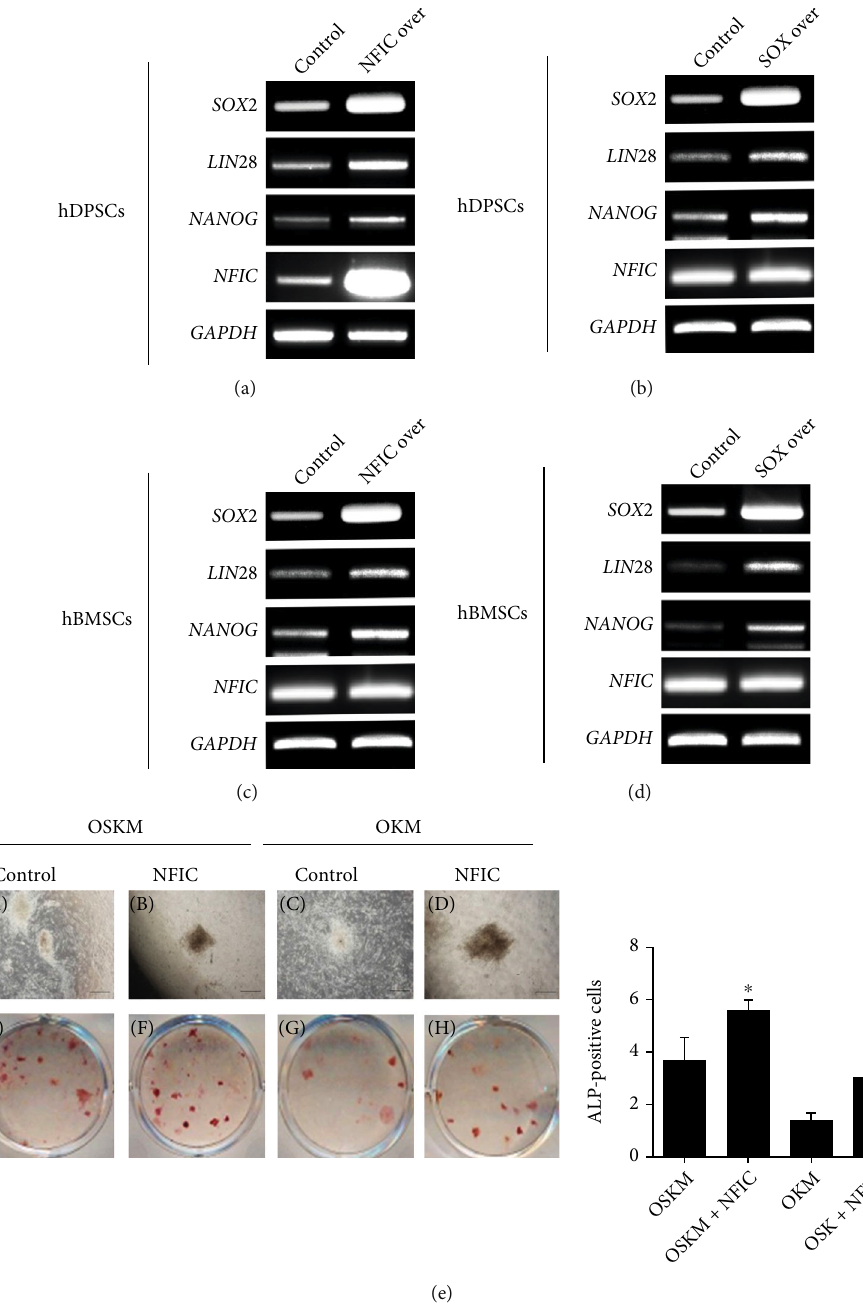
Figure 6: N fi c modulates pluripotency gene expression in mesenchymal stem cells of mineralized tissues. (a) Lin28 and Nanog gene expression levels were analyzed in control, N fi c -overexpressing, and (b) Sox2-overexpressing DPSC. (c) Lin28 and Nanog gene expression levels were analyzed in control, N fi c -overexpressing, and (d) Sox2-overexpressing BMSC. (e) (A – D) The number of ALP- positive colonies of iPSC cultured in OSKM medium compared to the addition of N fi c . (E – H) The number of ALP-positive colonies of iPSC cultured in OKM medium compared to the addition of N fi c . Scale bars = ð A Þ , ð C Þ , ð E Þ , ð G Þ = 200 μ m . (f) Quantitative analysis of the number of ALP-positive colonies in various conditioned media. Data are presented as the mean ± SD . Abbreviations: ALP: alkaline phosphatase; BMSC: bone marrow stem cell; Ctrl: control; DPSC: dental pulp stem cell; iPSC: induced pluripotent stem cell; OSKM, Oct4, Sox2, Klf4, c-Myc; OKM, Oct4, Klf4,